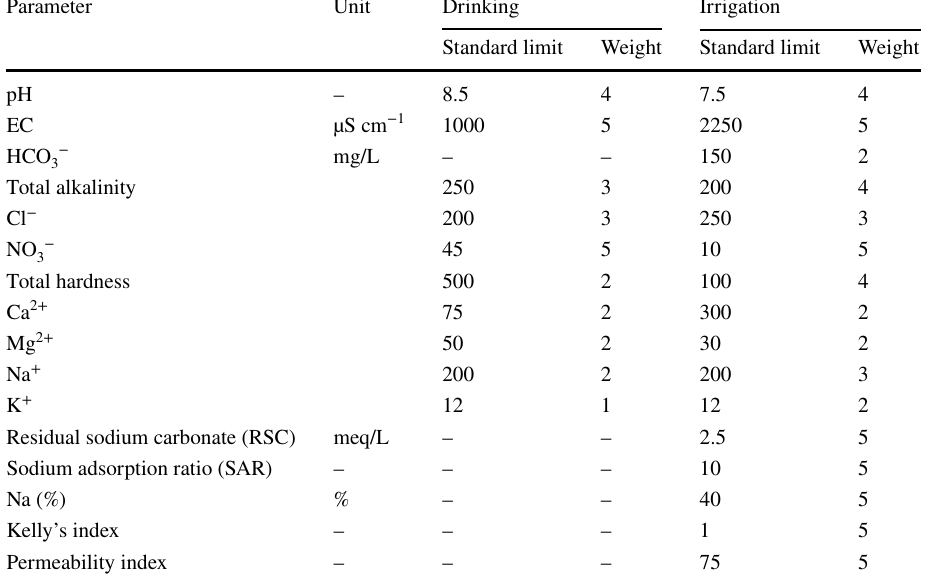
Table 1 Standard limits of water quality parameters and the weight of each chemical parameter used for calculating water quality index for drinking and irrigation